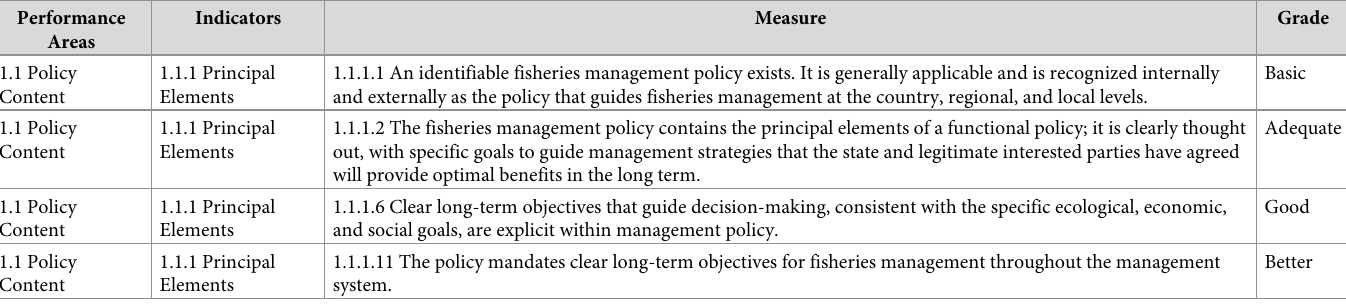
Table 2. An extract from Component 1 of the FGT showing measures within a single indicator ranging from basic to better. Whether the system meets each measure is assessed using the available data. Performance